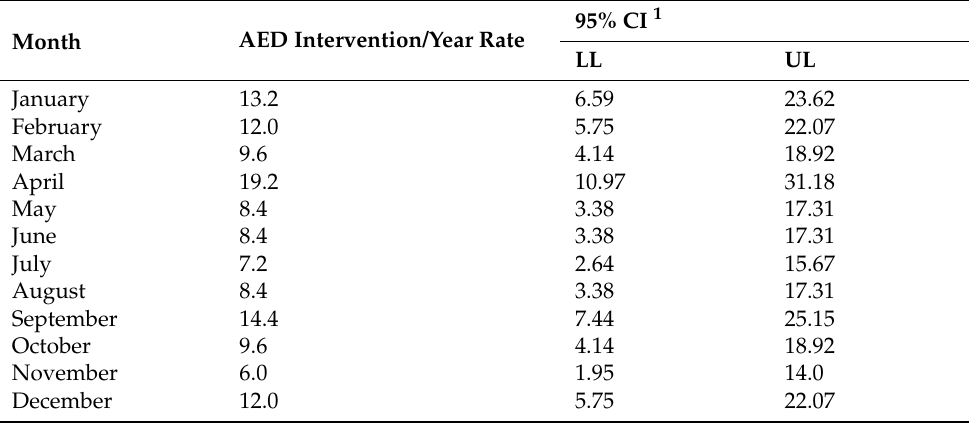
Table 5. Frequency of AED interventions by month.